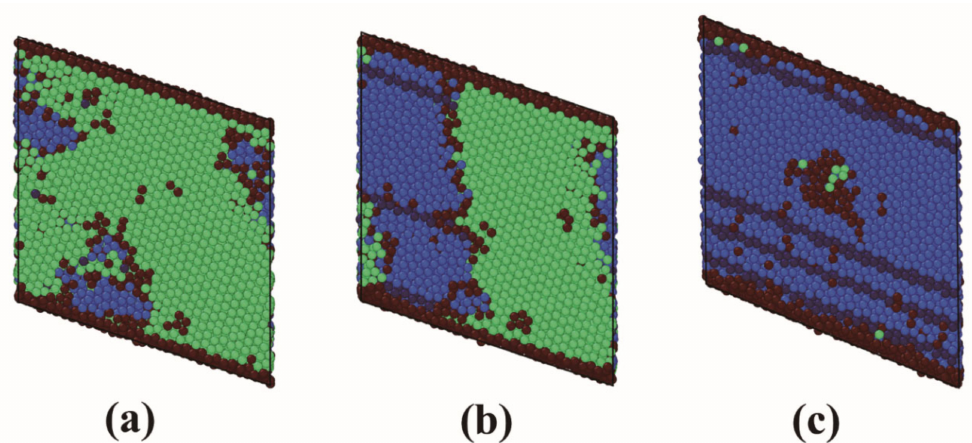
Figure A3. Snapshots of the ongoing austenitic phase transition in film 3 with the (111) bcc surface at 800 K. The simulation is performed using the Müller potential. The colors denote the local crystal structure as in Figure 5. The plane shown is the original (211) bcc plane. ( a ) Simultaneous nucleation of the new hcp phase at the free surface and in the bulk at a shear angle of 17.6 ◦ ; ( b ) Growth of the hcp phases nucleated at the surface and in the bulk material at shear angle of 23.3 ◦ . ( c ) Status at the largest shear angle of 26.5 ◦ . More SFs are formed due to the increasing shear